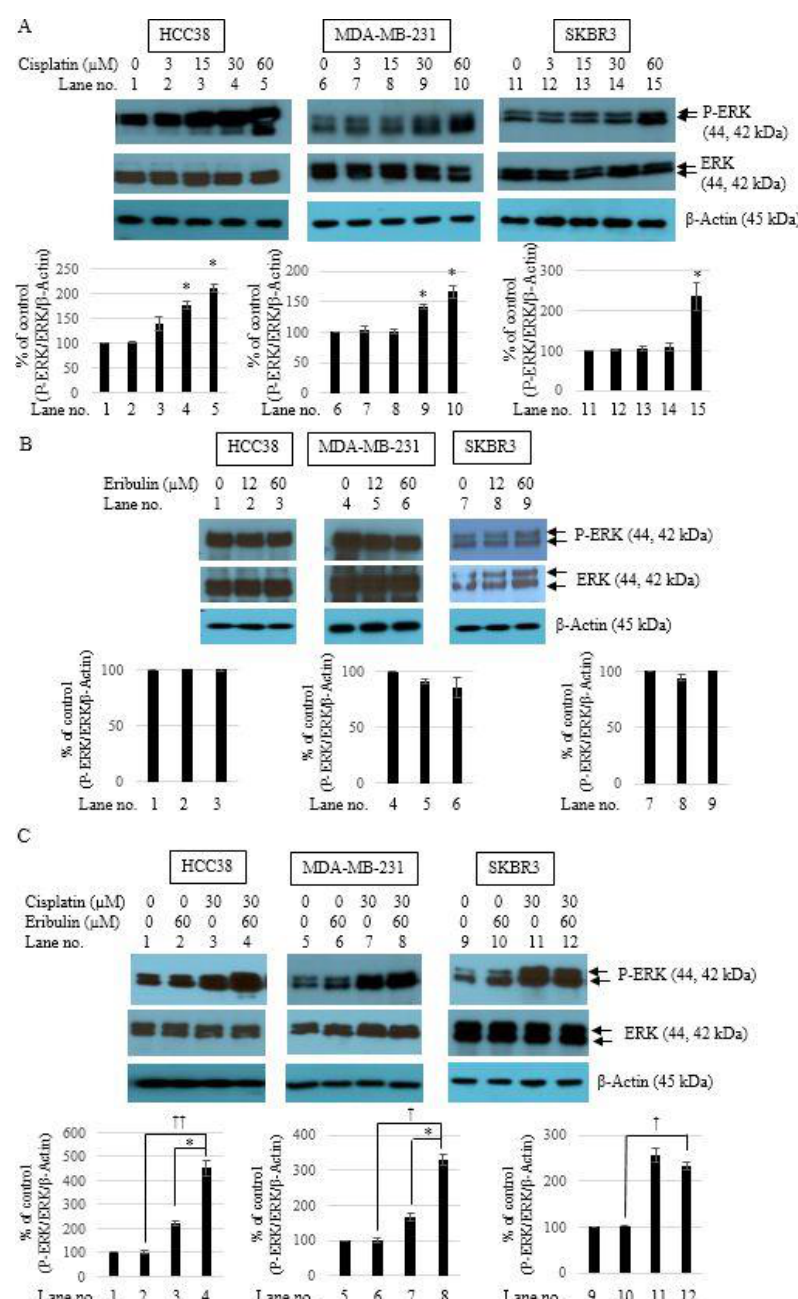
Figure 5. Eribulin and cisplatin in combination synergistically activated ERK activation in TNBC cells. HCC38, MDA-MB-231, and SKBR3 cells were exposed to cisplatin (3, 15, 30, and 60 µM) ( A ) or eribulin (12 and 60 µM) ( B ) for 24 h. Cell lysates were collected and subjected to Western blot analysis with anti-phospho-ERK1/2 and anti-ERK1/2 antibodies. β-Actin was used as the internal control. Data are presented as the mean ± standard deviation; * p < 0.05 vs. untreated control. ( C ) Cells were exposed to cisplatin (30 µM) or eribulin (60 µM) individually or in combination for 24 h. Levels of phosphorylated ERK1/2 and total-ERK1/2 were assessed by Western blot analysis. β-Actin was used as the internal control; * p < 0.05 vs. cisplatin-only (30 µM) treatment, † p < 0.05, †† p < 0.01 vs. eribulin-only (60 µM) treatment.